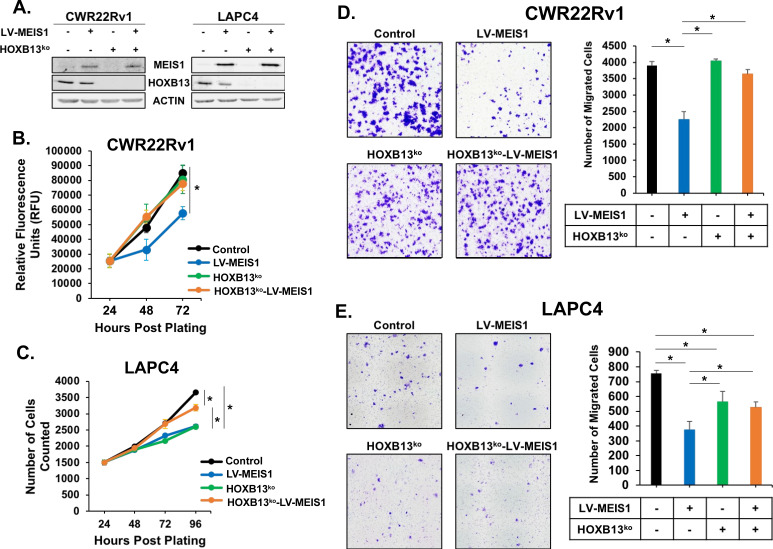
MEIS-mediated suppression of proliferation and migration is dependent upon HOXB13.(A) Western blot analysis of HOXB13 knockout using CRISPR and exogenous expression of MEIS1 in the resulting HOXB13ko cells for CWR22Rv1 and LAPC4. Actin was used as a loading control. (B-C) Proliferation of CWR22Rv1 (B) and LAPC4 (C) cells expressing control (black) or LV-MEIS1 (blue); or with HOXB13ko (green) or HOXB13ko and LV-MEIS1 expression (orange). Cell number over time was assessed using CyQuant direct cell proliferation kit. Data represent mean and SEM at each timepoint (technical replicates, n = 3). (D-E) Representative 10x images (left) and quantitation (right) of transwell migration assay for CWR22Rv1 (D) and LAPC4 (E) cell line derivatives. Data represent mean number of cells counted (technical replicates, n = 3) and SEM. *Student’s t-test p<0.05 for all panels. See also Figure 3—figure supplement 1.